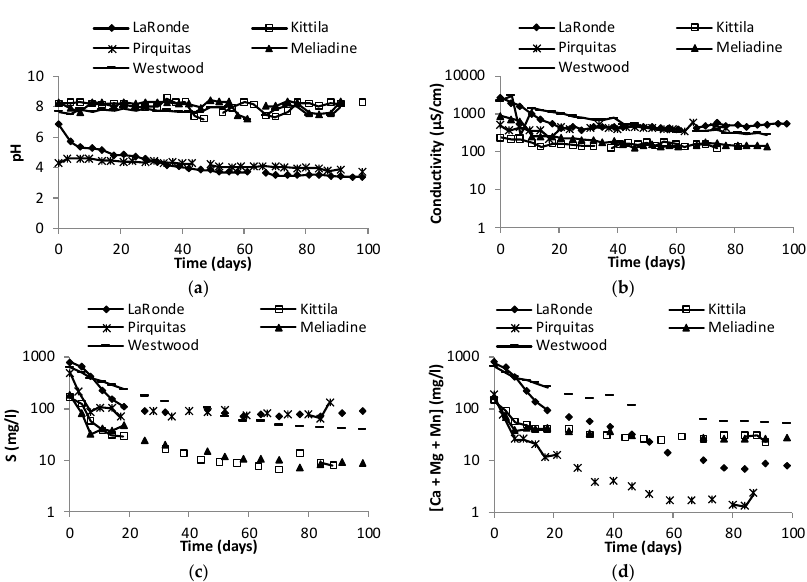
Figure 4. Geochemical results from the weathering cells: ( a ) pH and ( b ) electrical conductivity; ( c , d ) concentrations (mg/L) of metals associated with sulfide oxidation in the ore samples: ( c ) S, ( d ) Ca + Mg + Mn. The concentrations of elements associated with metal sulfide oxidation (sulfates and metals) are shown in Figure 5. Despite their content in the solid samples, no Bi concentrations were found in the leachates. Pb was found in the first flush for Pirquitas, and in the leachates of LaRonde (average of 0.6 mg/L). Mo was found in the leachates of Meliadine. Hg, Sn and Tl were not analyzed. Table 4 presents the average and median leachate concentrations in mg/l and the initial content in the solid samples. Although all the ores contain Sb in significant amount, it was only found in the leachates with an acidic pH (LaRonde and Pirquitas).